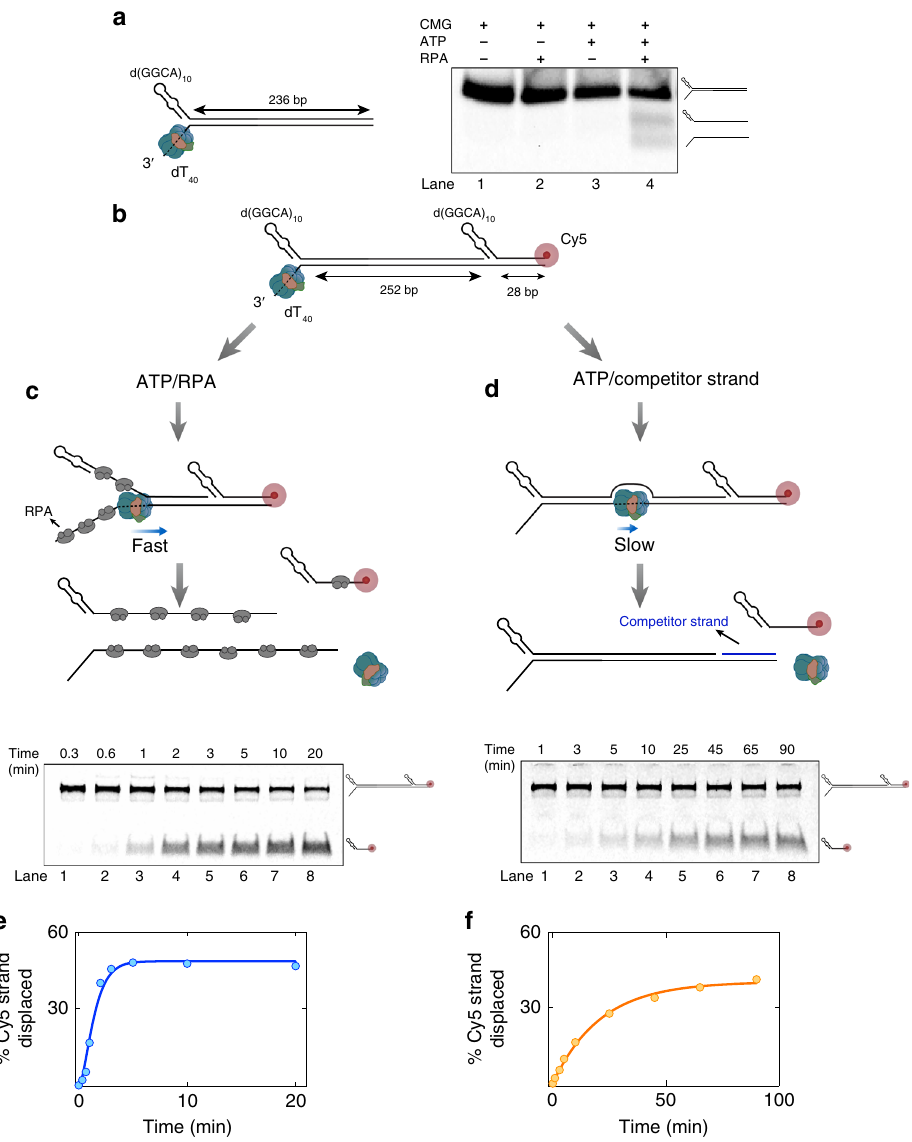
Fig. 2 RPA increases the rate of DNA unwinding by CMG. a Fork DNA containing 236-bp dsDNA was incubated with CMG in the presence of ATP γ S for binding to 3 ′ dT 40 tail. ATP was added with (lane 4) or without (lane 3) RPA and incubated further before separating on 3% agarose. DNA was labeled internally with multiple Cy5 fl uorophores on both strands. This experiment was performed once. b Fork DNA substrate containing 252-bp long dsDNA, followed by 28-bp duplex and Cy5-modi fi cation on the excluded strand was bound by CMG. ATP was added to initiate translocation by the helicase. c CMG-mediated displacement of Cy5-labeled strand in the presence of RPA. When included in ATP buffer, RPA prevents reannealing of DNA behind the helicase as well as new CMG binding. d CMG-mediated displacement of Cy5-labeled strand in the absence of RPA. DNA rewinds within the 252-bp duplex region. To prevent rehybridization of the Cy5-labeled strand to long DNA substrate, excess competitor oligonucleotide containing complementary 28-nt sequence to long DNA was added with ATP. To achieve single-turnover kinetics, excess dT 40 oligonucleotide was included in ATP buffer that captures any free CMG. e , f Percentage of Cy5-modi fi ed strand displaced versus time by CMG in the presence e and absence of RPA f . The data in c – f represent mean from n = 2 independent experiments, and were fi t to Eq. (1) with m = 1 or 2 (see Methods) resulting in best R 2 value. Solid lines are fi ts to Eqs. (2) and (3) in e and f , respectively. Source data are provided as a Source Data fi